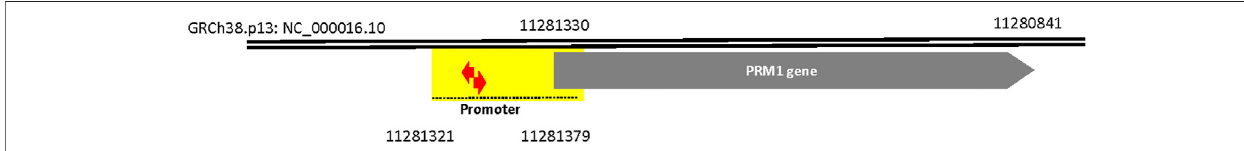
FIGURE 1 | Genomic locations of PRM1 gene, promoter (dashed line), gRNAs (red arrows) and Chip region (yellow highlight). CRCh38.p13:NC_000016.10 is the chromosomal location of PRM1 gene and it promoter. The numbers on the fi gure are nucleotide positions.